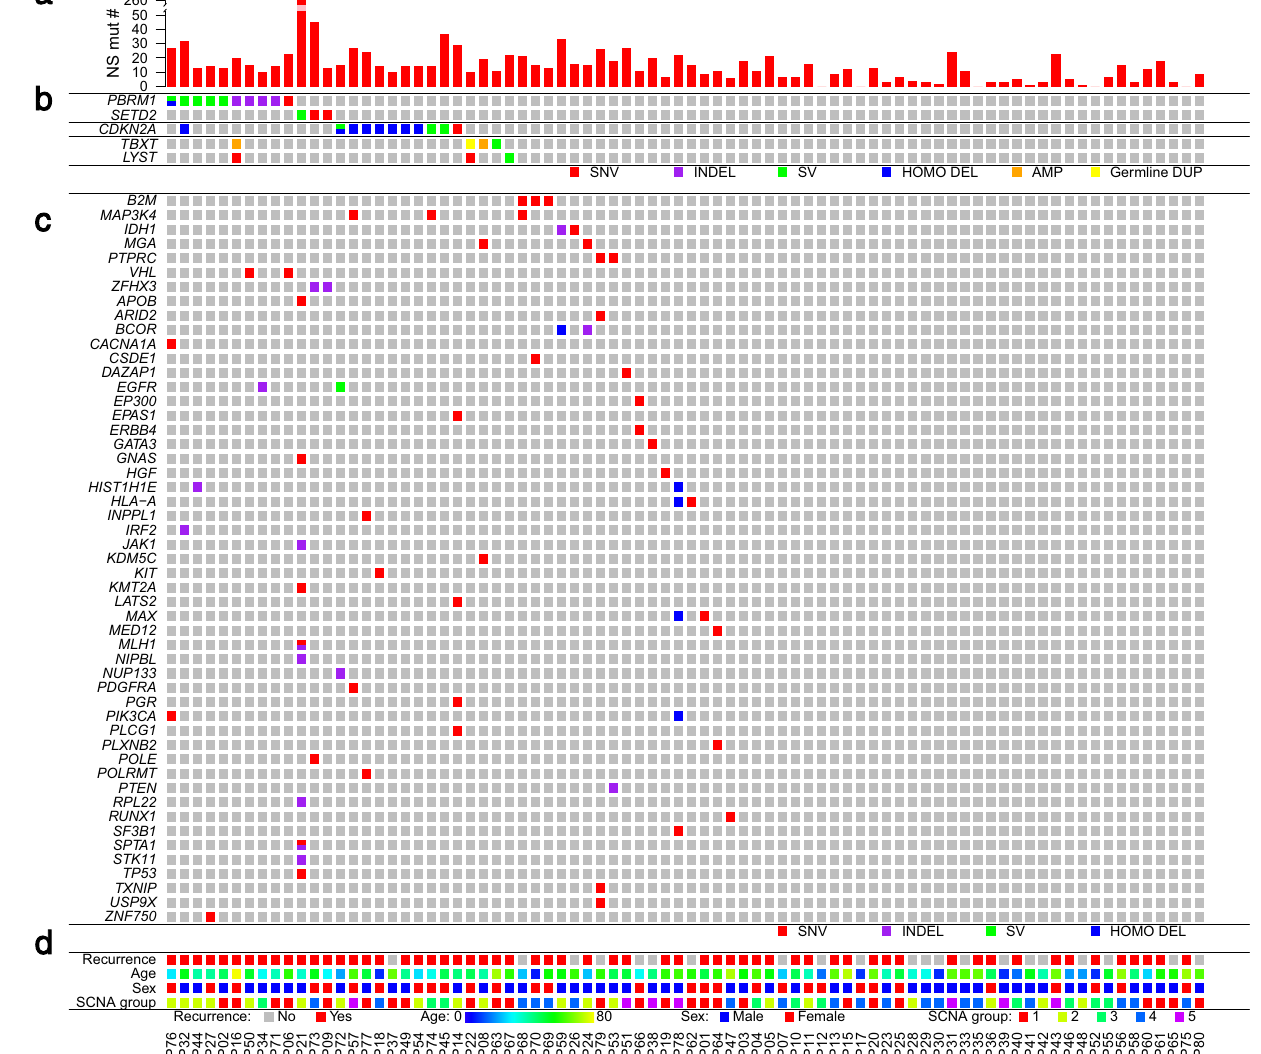
Fig. 2 Genomic driver landscape of skull-base chordoma. a The number of nonsynonymous (NS) mutations per tumor. b The potential chordoma driver genes. c The middle gene panel reports NS mutations in known cancer driver genes that were detected in this study. SNV single nucleotide variant, SV structural variant, HOMO DEL homozygous deletion, AMP ampli fi cation, Germline DUP germline duplication. d The recurrence status (no: gray; yes: red), age (from younger to older: blue to yellow), sex (female: red; male: blue), and SCNA group (see Fig. 3). See also Supplementary